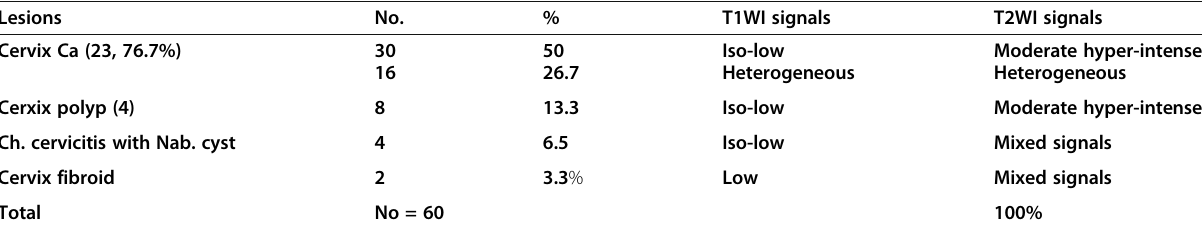
Table 2 Multiparametric MRI findings in the all studied uterine cervix focal lesions (number = 60) Lesions No. % T1WI signals T2WI signals Cervix Ca (23,